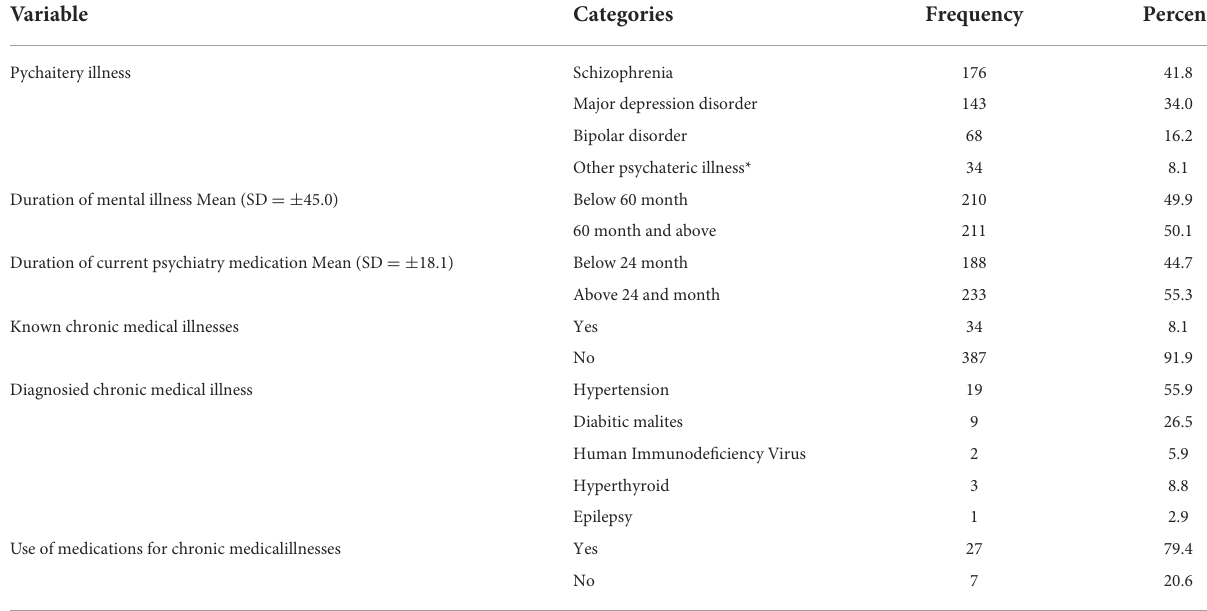
TABLE 2 Psychiatric and medical clinical diagnosis among respondents attending follow-up treatment in the University Medical Center Psychiatry Clinic, Jimma, southwest Ethiopia, 2022 ( N = 421).